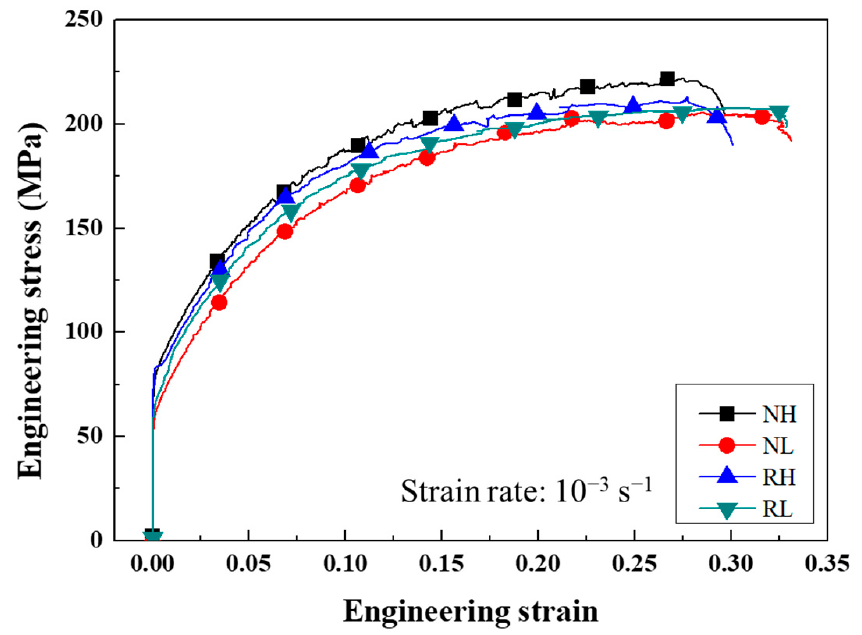
Figure 7. Engineering stress–strain curves in the RD of recrystallized sheets.